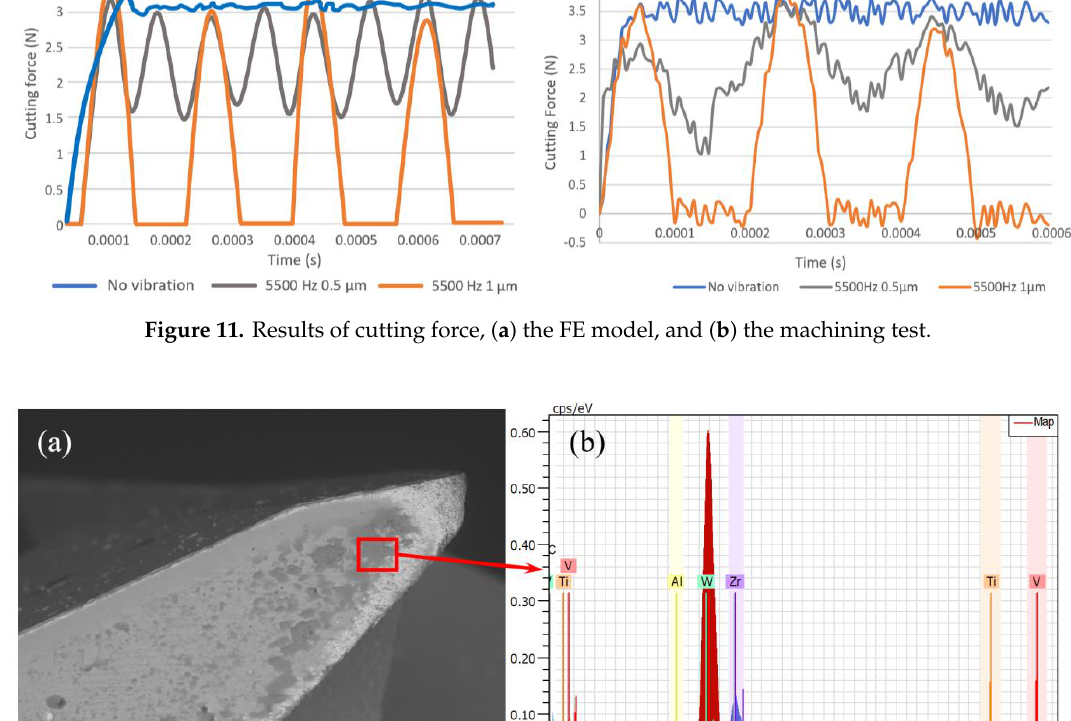
Figure 11. Results of cutting force, ( a ) the FE model, and ( b ) the machining test.